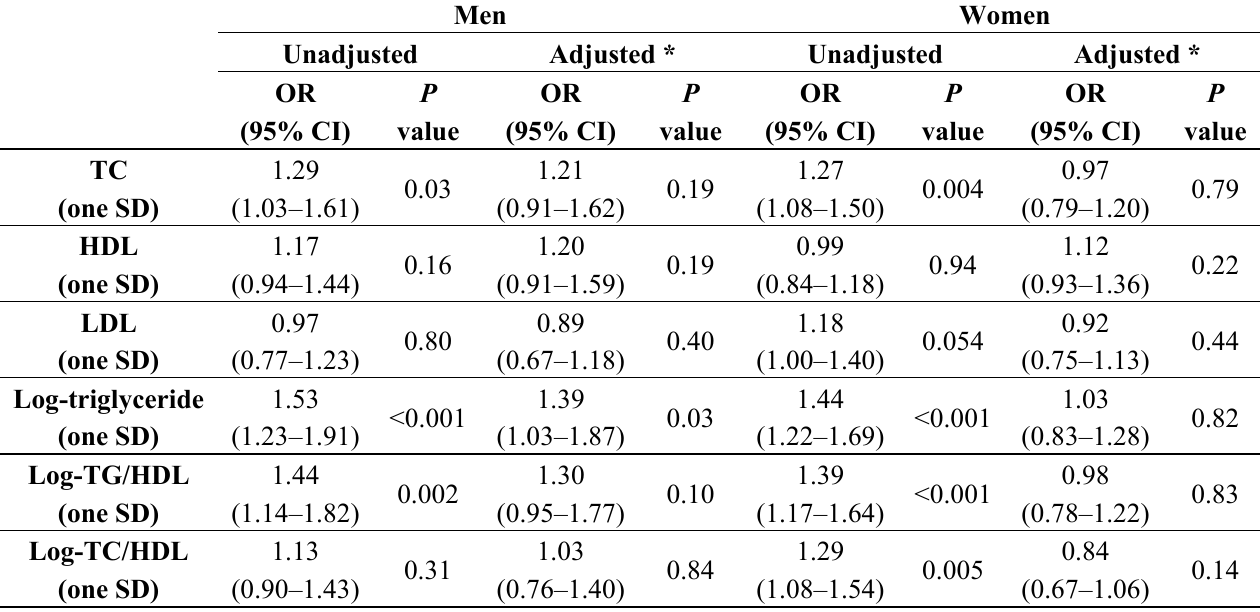
Table 2. Association of serum lipids and lipid ratios with Chronic Kidney Disease (CKD) in male and female